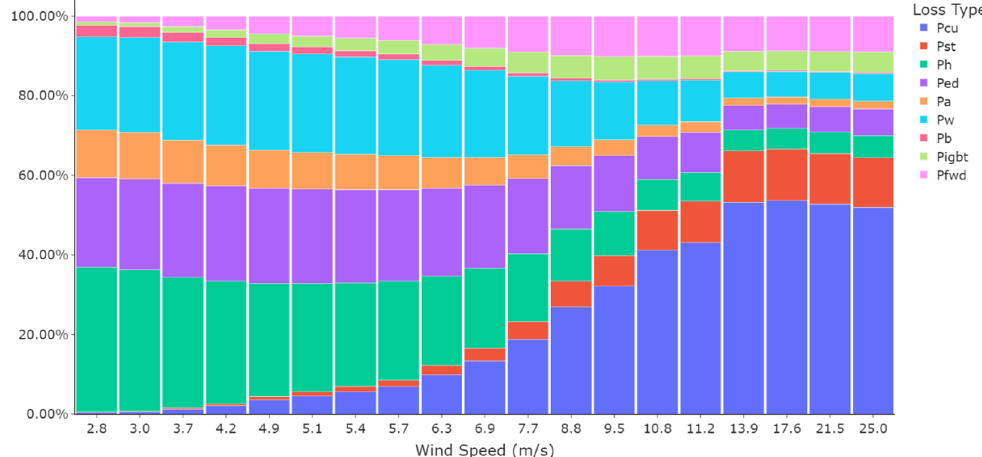
Figure 4. Distribution of the power losses in different stages of a direct-drive wind turbine.